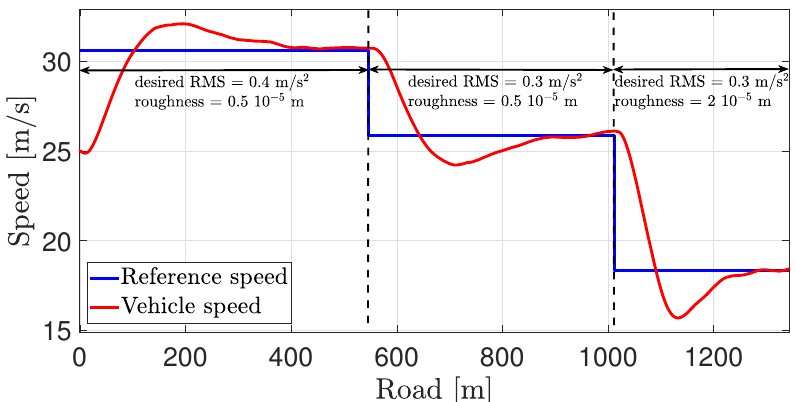
Figure 20. Resulting reference and vehicle speed.